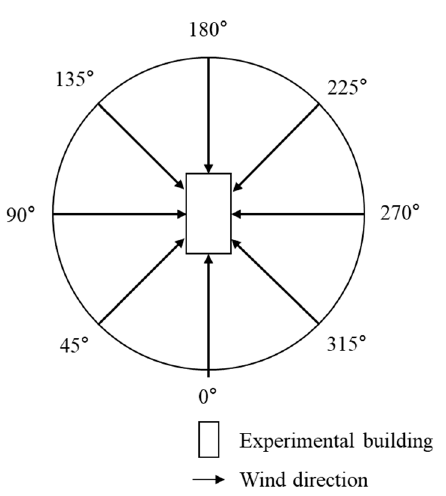
Figure 7. Definition of wind direction based on the experimental building.